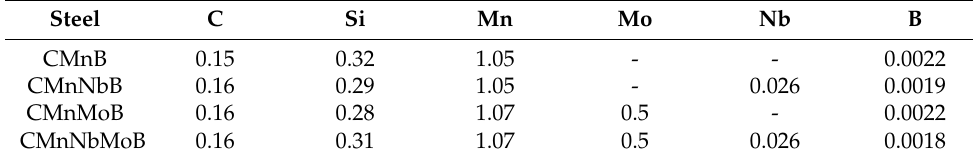
Table 1. Chemical composition of the studied steels (weight